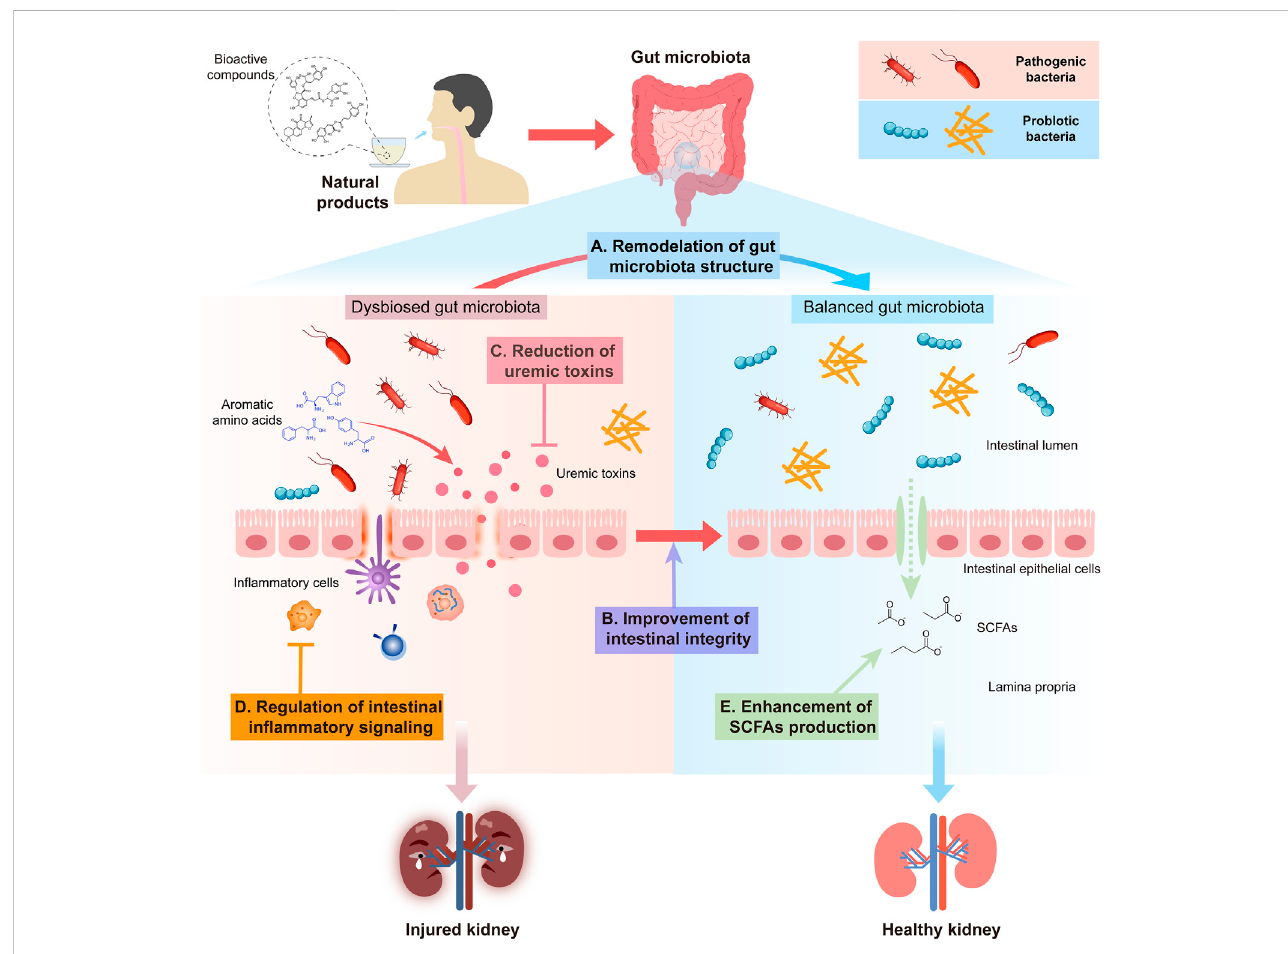
FIGURE 1 Schematic graphic representation of strategies of gut microbiota as an alternative target for natural products from plants and microorganisms in the treatment of CKD. The strategies of these anti-CKD effects of herbal medicine include (A) remodulation of the gut microbiota structure; (B) improvement in intestinal integrity; (C) reduction of uremic toxins; (D) regulation of intestinal in fl ammatory signaling; and (E) enhancement of SCFA